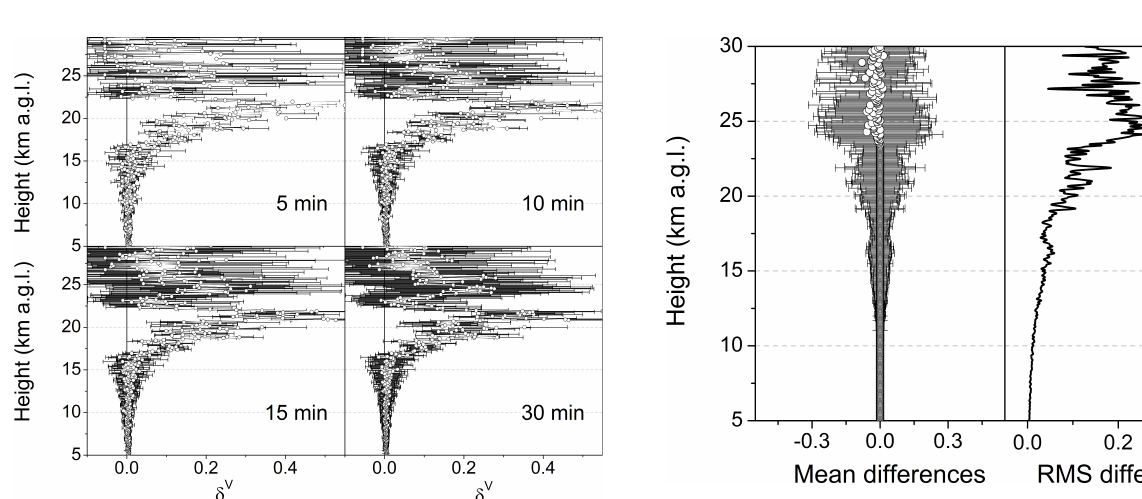
Fig. 2. MPL-4 δ V profiles (white-lined open circles, in black back- ground of their SD values) on 1 July 2009 depending on the time averaging (see legend inside each panel, from up to down and right to left): 5-, 10-, 15- and 30-min averaged profiles.